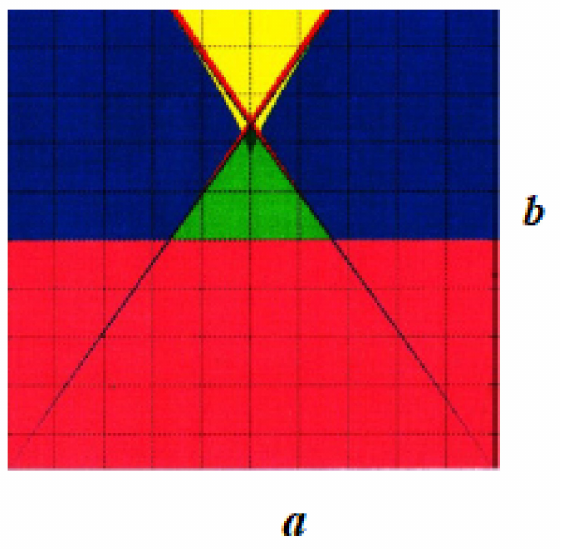
Figure 3. Bifurcation diagram of the Gierer–Meinhardt MCNN model. Local activity region—dark pink, blue is a locally passive region, edge of chaos domain is red, green is a locally active and unstable region, yellow is the region in which no equilibrium point is both locally active and stable.